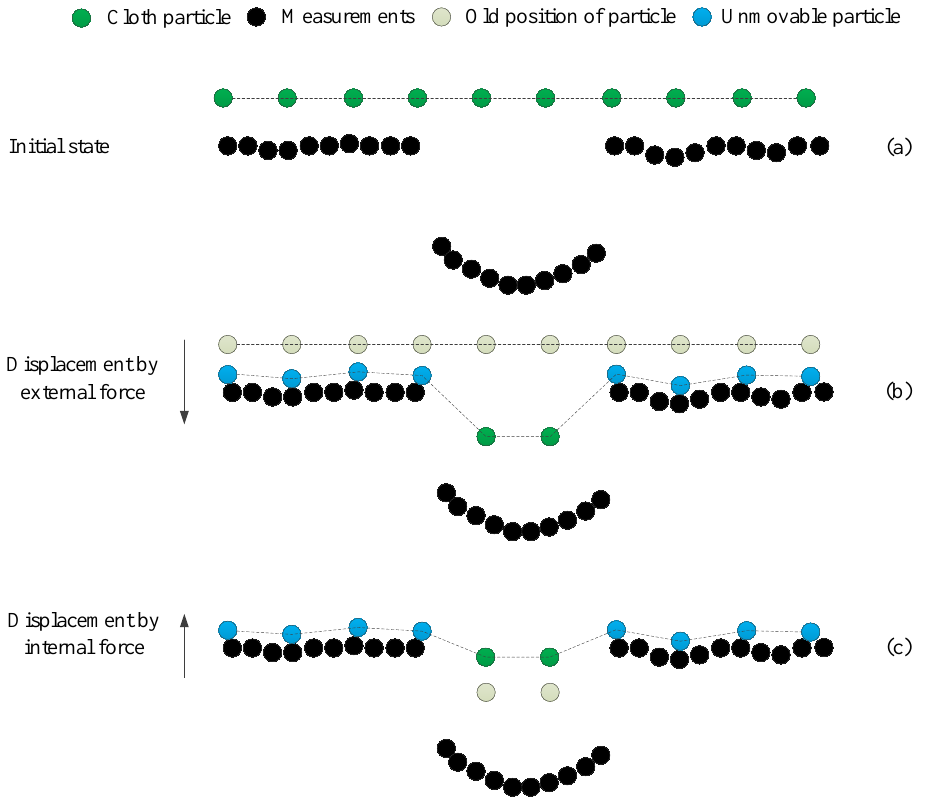
Figure 4. Procedure of cloth simulation (CS): ( a ) Initial state. A cloth is placed above the inverted measurements. ( b ) Each particle drops to the inverted measurements under the external force, and their displacement is computed based on the second law of Newton. If the cloth particles collide with the measurements, these particles will stop falling and be labeled unmovable particles. ( c ) Except for unmovable particles, each particle is moved according to the internal force produced by neighboring particles. Steps ( b ) and ( c ) are repeated until the maximum height variation of all particles is sufficiently small.